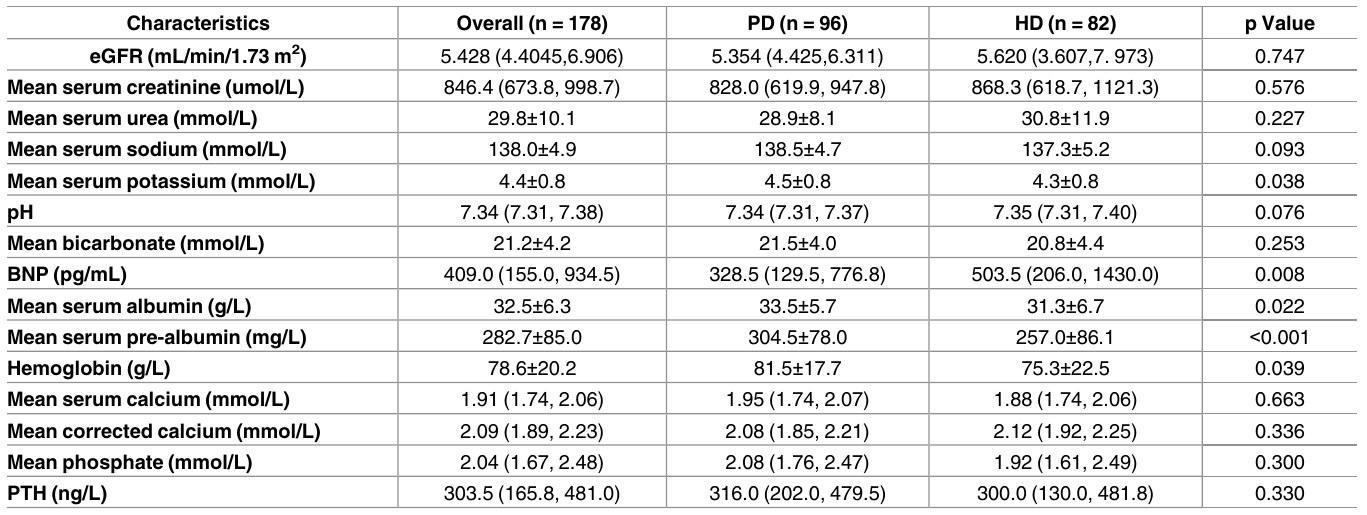
Table 2. Baseline Laboratory Characteristics of the Study